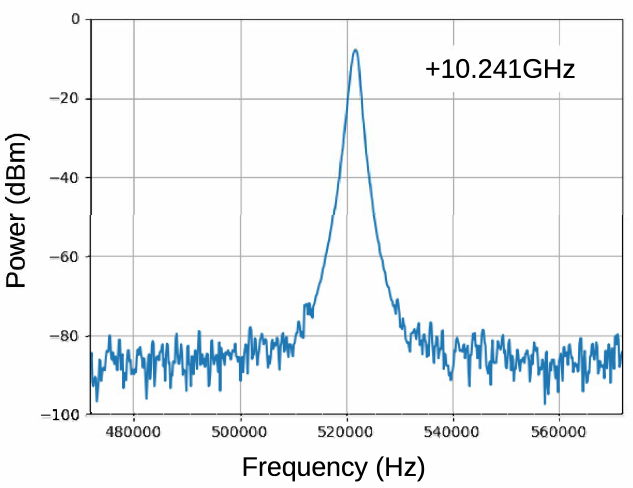
Figure 12. Output spectrum. Frequency span is 100 kHz with 10.241 GHz offset.